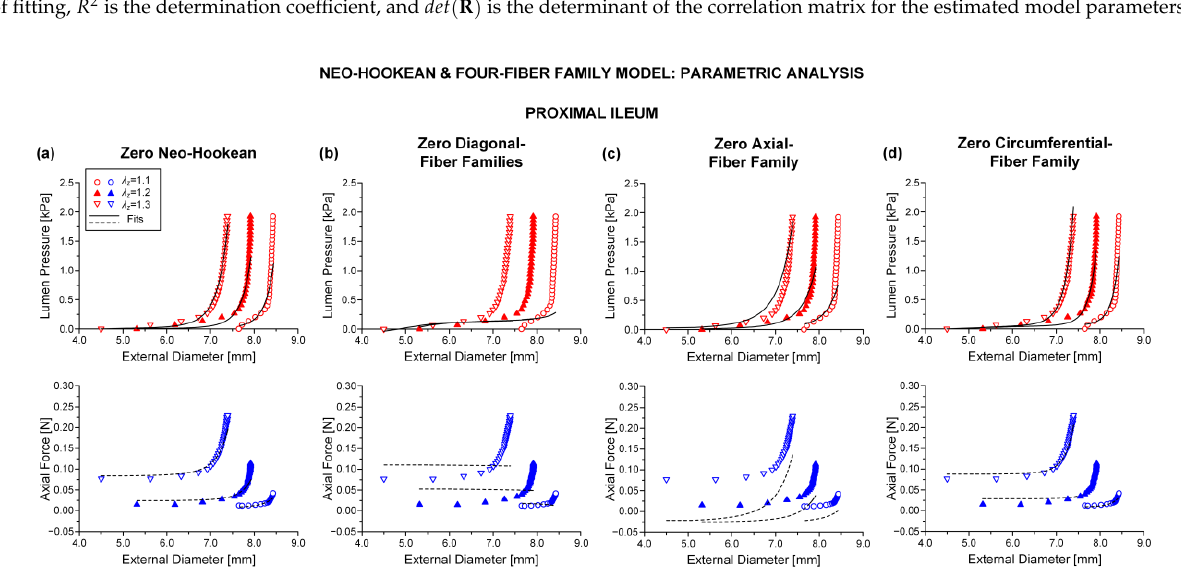
Figure 5. Plots of measured data from the characteristic proximal ileum specimen shown in Figure 4 and fits by the neo-Hookean and four-fiber family model with vanishing ( a ) neo-Hookean term: 𝜇 = 0 kPa, 𝑘 1𝑑 = 0.027 kPa, 𝑘 2𝑑 = 5.128, 𝑘 1𝑎 = 1.544 kPa, 𝑘 2𝑎 = 2.524, 𝑘 1𝑐 = 8.3 × 10 −11 kPa, 𝑘 2𝑐 = 0.086, 𝑎 0 = 0.512 rad, ε = 0.269, 𝑅 2 = 0.899, 𝑑𝑒𝑡(𝐑) = 1.7 × 10 −5 , ( b ) diagonal-fiber families: 𝜇 = 0.307 kPa, 𝑘 1𝑑 = 0 kPa, 𝑘 2𝑑 = 0, 𝑘 1𝑎 = 4.488 kPa, 𝑘 2𝑎 = 0.812, 𝑘 1𝑐 = 0.002 kPa, 𝑘 2𝑐 = 0.295, 𝑎 0 = 0.785 rad, ε = 0.687, 𝑅 2 = 0.336, 𝑑𝑒𝑡(𝐑) = 0.001, ( c ) axial-fiber family: 𝜇 = 3.5 × 10 −9 kPa, 𝑘 1𝑑 = 0.110 kPa, 𝑘 2𝑑 = 4.471, 𝑘 1𝑎 = 0 kPa, 𝑘 2𝑎 = 0, 𝑘 1𝑐 = 6.6 × 10 −9 kPa, 𝑘 2𝑐 = 0.020, 𝑎 0 = 0.487 rad, ε = 0.394, 𝑅 2 = 0.782, 𝑑𝑒𝑡(𝐑) = 9.4 × 10 −5 , and ( d ) circumferen-